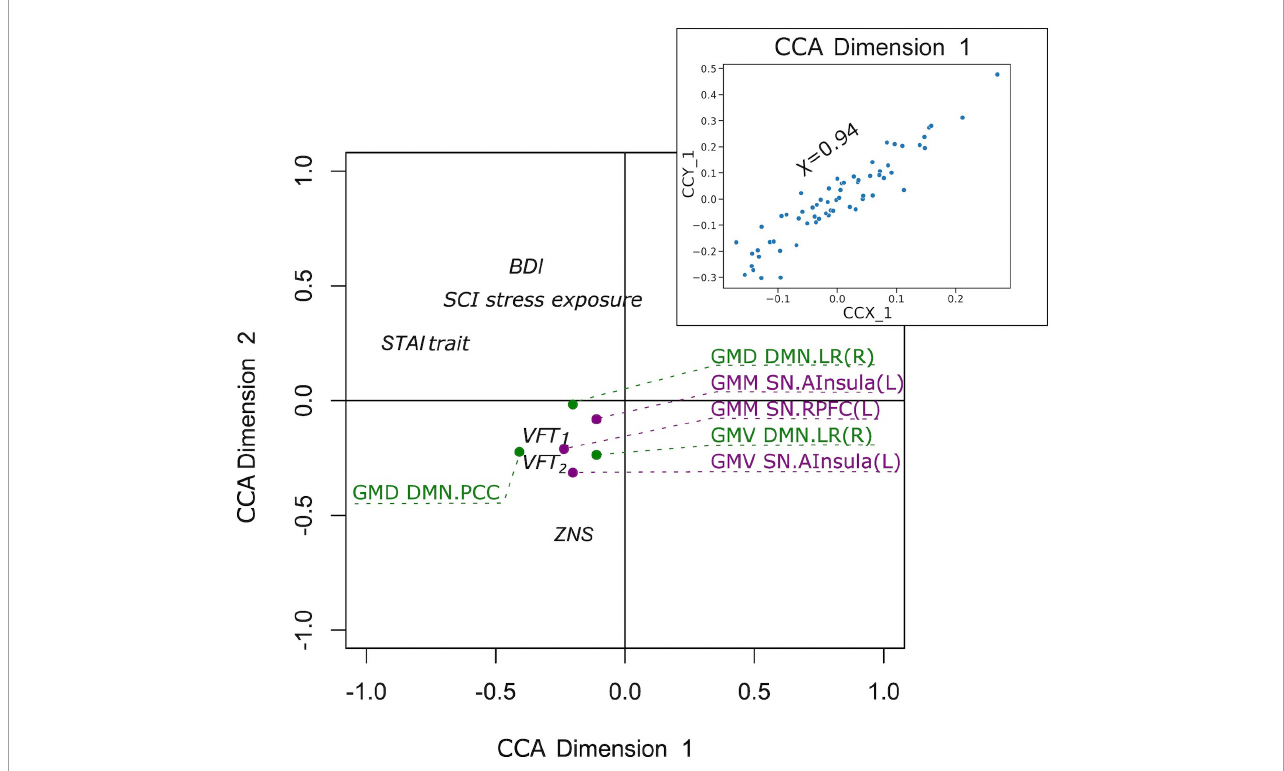
FIGURE7 Correlation of the first canonical correlation analysis (CCA) mode variables for the full sample (upper right), and contributions of the variables to the first and second CCA